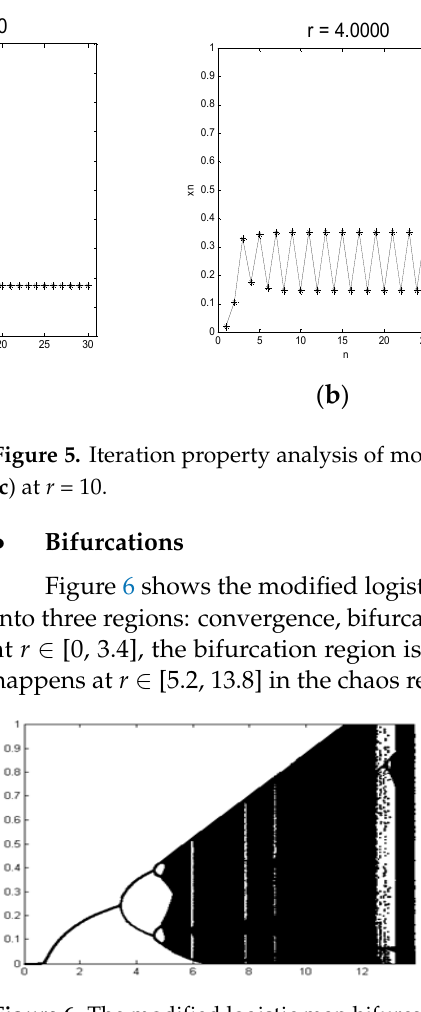
Figure 6. The modified logistic map bifurcation diagram at r ∈ [0, 13.8], and X 0 = 0.02